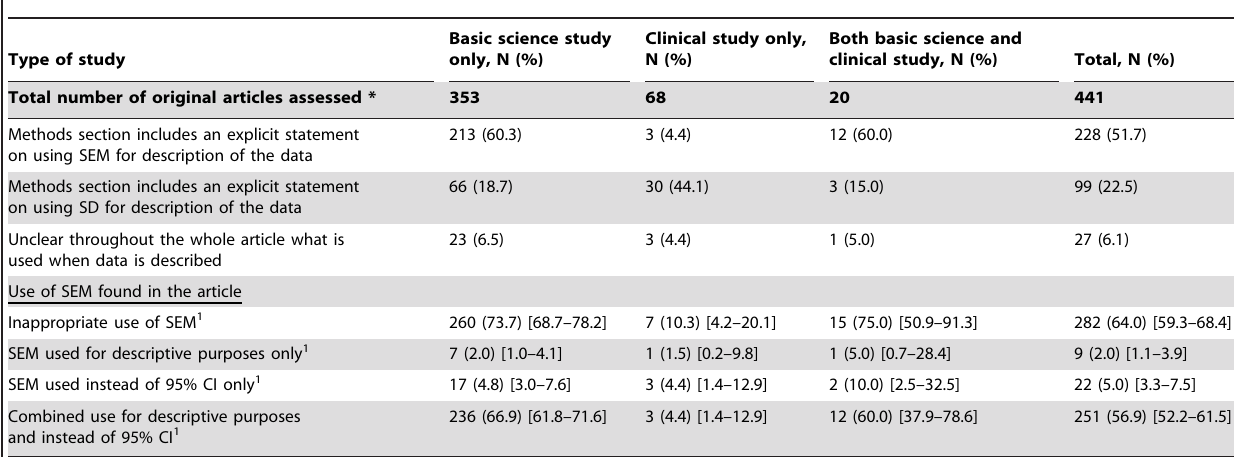
Table 2. Results of use of SEM by type of study in three cardiovascular journals (Cardiovascular Research, Circulation: Heart Failure, Circulation Research) edited in the year